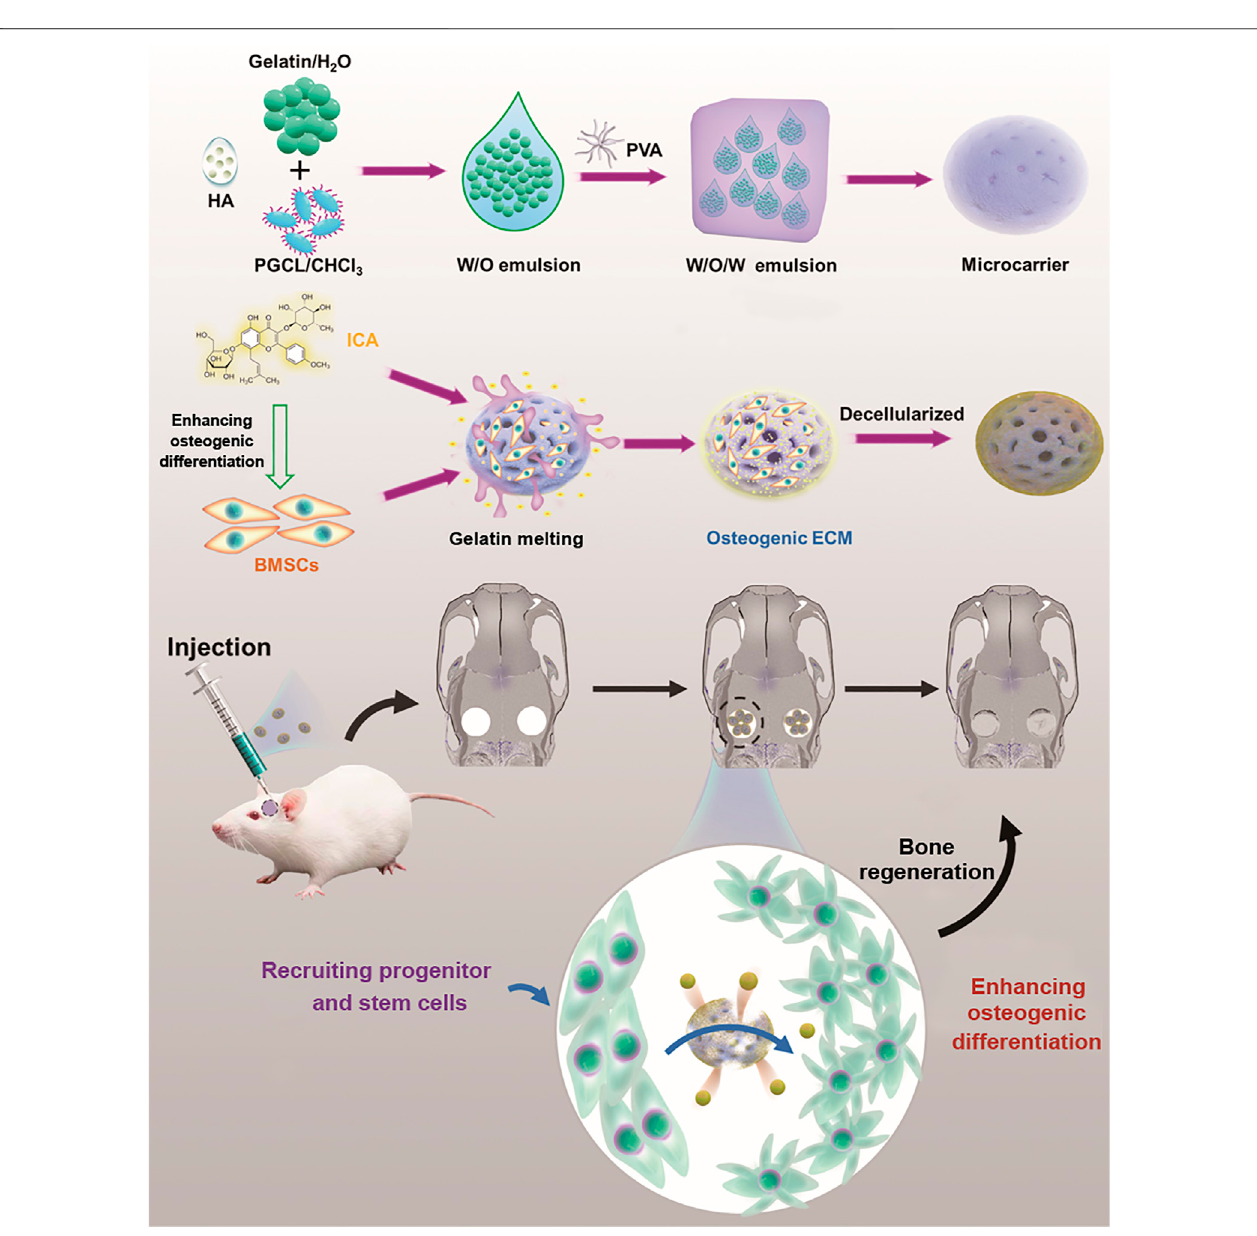
FIGURE 1 | Schematic diagram of ICA-loaded microcarriers with ECM coating for rat calvarial bone regeneration.